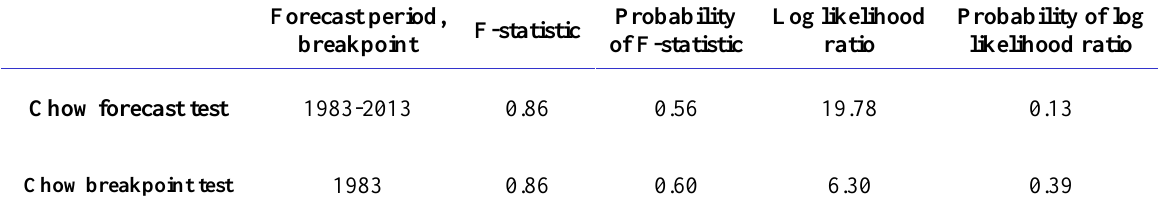
Table 7. Statistical output for stability test Forecast